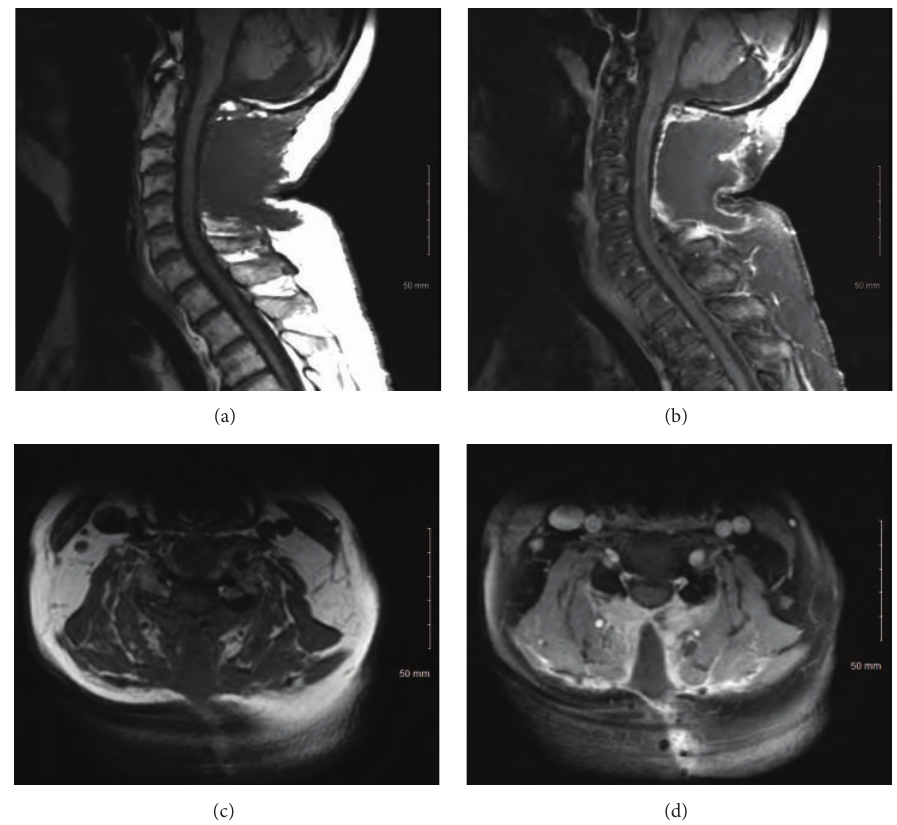
Figure 4: T1-sequence MRI of the cervical spine obtained 2 months postoperatively. Sagittal images without (a) and with (b) gadolinium contrast material and axial images without (c) and with (d) gadolinium, showing complete resolution of the enhancing lesion.